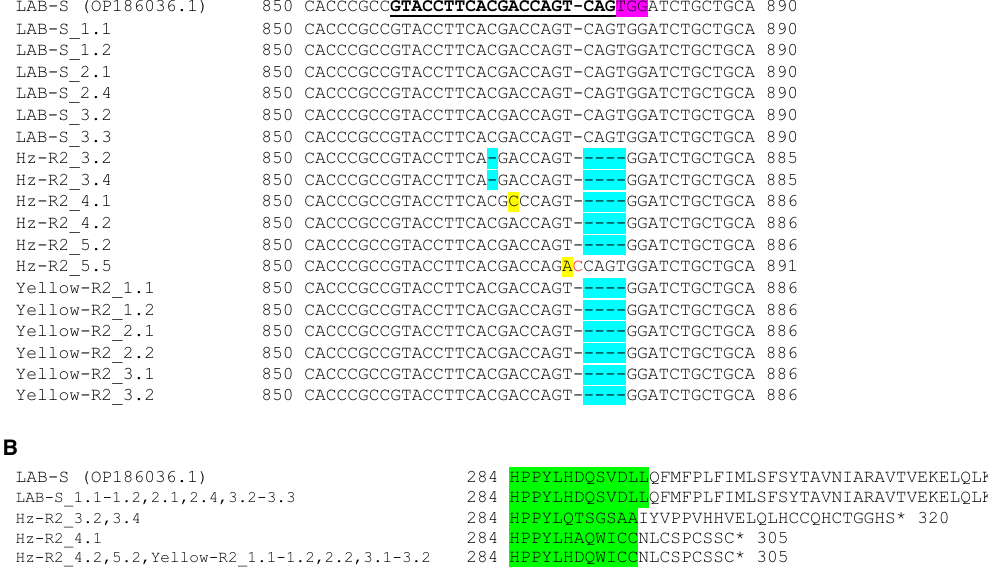
Figure 2. Mutations in HzABCA2 gDNA and the resulting translated sequences from three Hz-R2 larvae and three Yellow-R2 that survived exposure to diet treated with 1 μg Cry2Ab per cm 2 diet. ( A ) Partial HzABCA2 genomic DNA fragments corresponding to HzABCA2 sgRNA 7 were cloned and Sanger sequenced. Two clones from each of three Hz-R2 larvae and three Yelllow-R2 larvae (2 clones × 3 individuals) and two clones from three LAB-S moths were sequenced. HzABCA2 sgRNA 7 sequence is bold and underlined. The PAM sequence is highlighted in pink. The DNA insertion is shown with red text, deletions are highlighted in blue, and substitutions are highlighted in yellow. Numbers indicate nucleotide position in the HzABCA2 mRNA because only the exon section is shown. ( B ) Alignment of translated HzABCA2 partial amino acid sequences from the Yellow-R2 and Hz-R2 G 1 survivors on 1 μg Cry2Ab per cm 2 . Amino acids highlighted in green correspond to the gDNA Sanger sequenced for the corresponding HzABCA2 sgRNA 7 target site. Stars indicate premature stop codons. Numbers indicate the position of the amino acid in the HzABCA2 protein